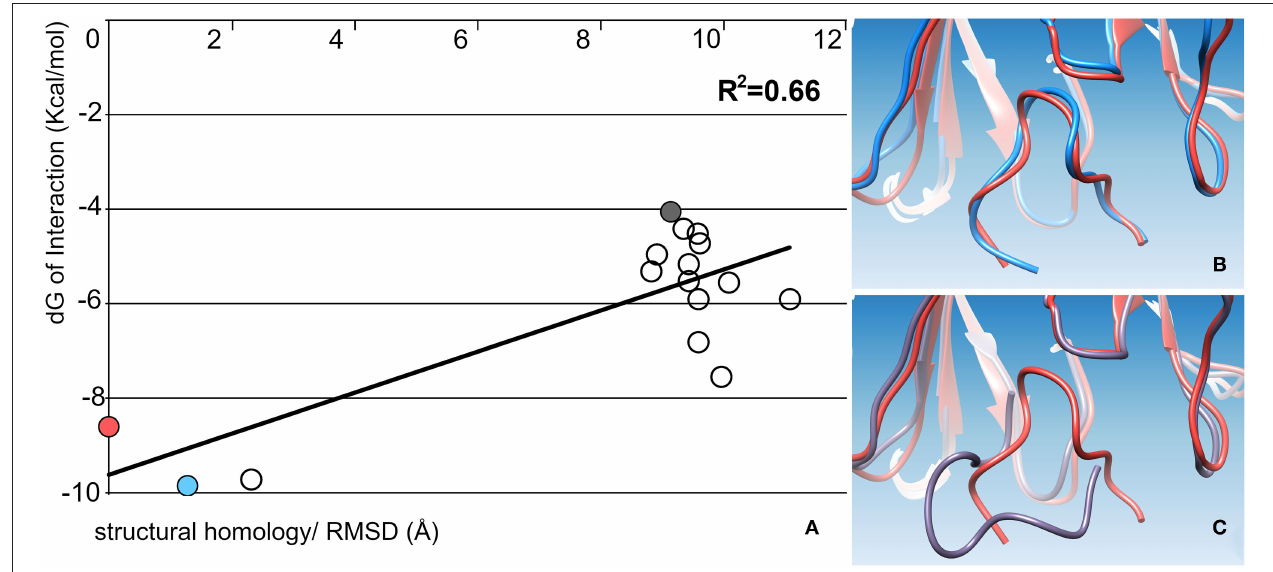
FIGURE 3 | Ag–Ab focused-docking recapitulation for an FMDV interaction complex of reference. The figure displays data for 16 Ag–Ab candidate interaction complexes. (A) Regression plot between interface energy score (dG) and RMSD for each Ag–Ab candidate solutions. (B,C) exemplifies the structural alignment (of the main chains) between mAbs, revealing the structural distance of FMDV peptide in the wt complex (orange), compared with a top (pale blue), and to a poor (gray) dG scored